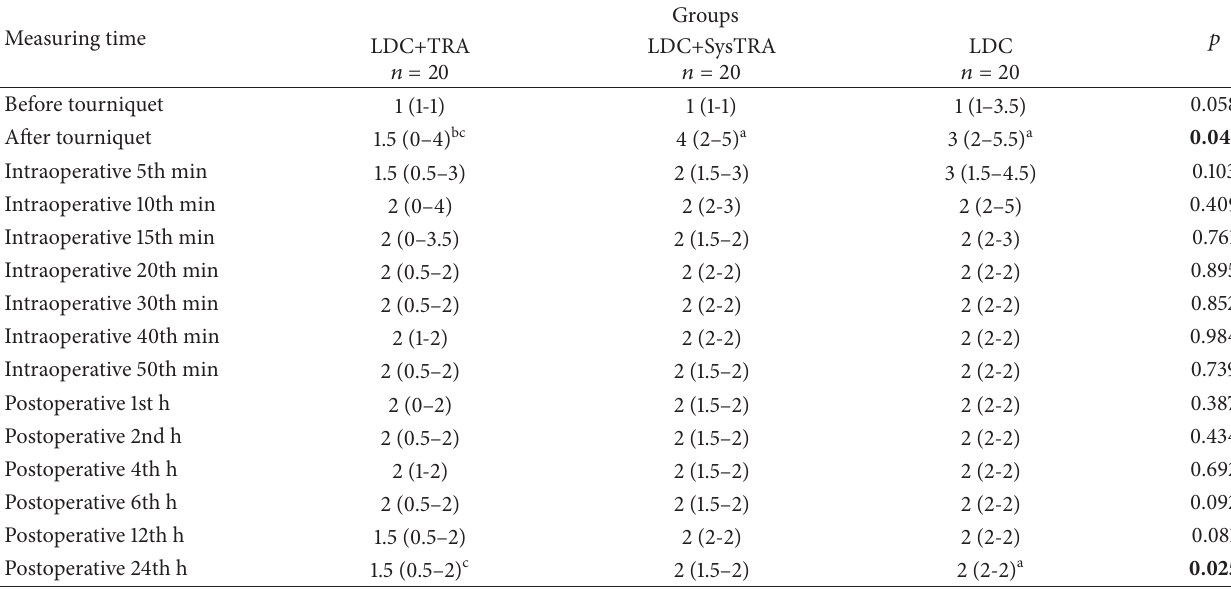
Table 3: Visual analogue scale scores at different times.